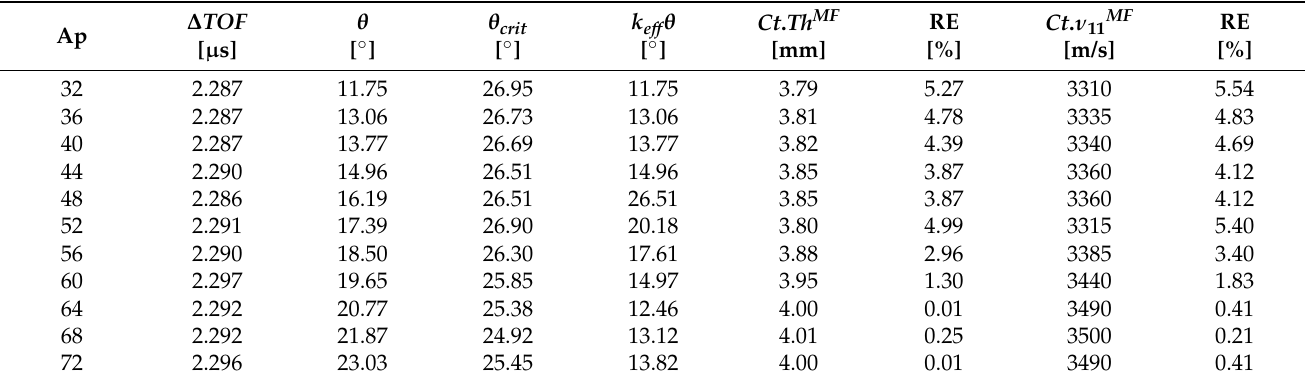
Table A1. Results of Ct . Th MF , Ct . ν 11 MF and relative errors (RE) for the bone plate models with different element apertures using shift in time-of-flight between confocal front-and back reflections ∆ TOF , semi-aperture angle θ crit for the effective aperture k eff θ .